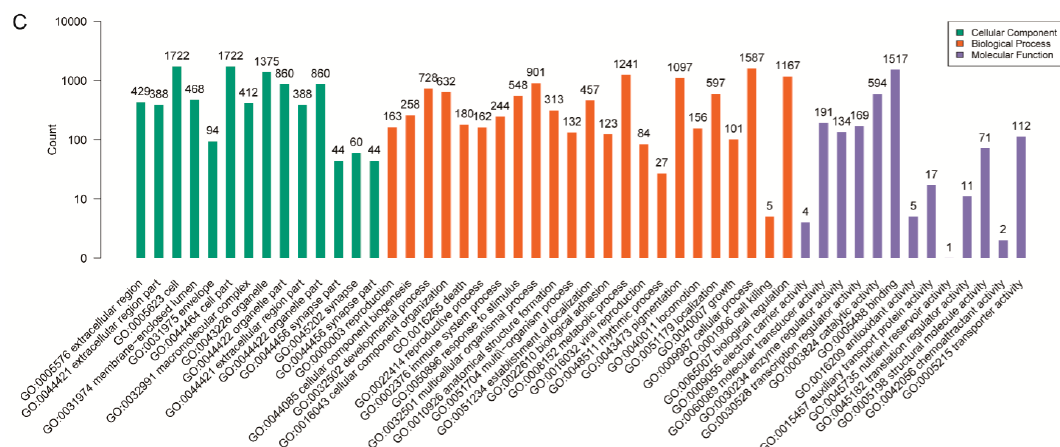
Figure 1. DMRs between lymph node carcinoma of the cancer prostate—artificially induced—flutamide (LNCaP-AI-F) and LNCaP cells. ( A ) Distribution of DMRs by gene structure; ( B ) Distribution of DMRs by functional elements; ( C ) Functions of genes whose promoters overlapped with DMRs. DMRs: